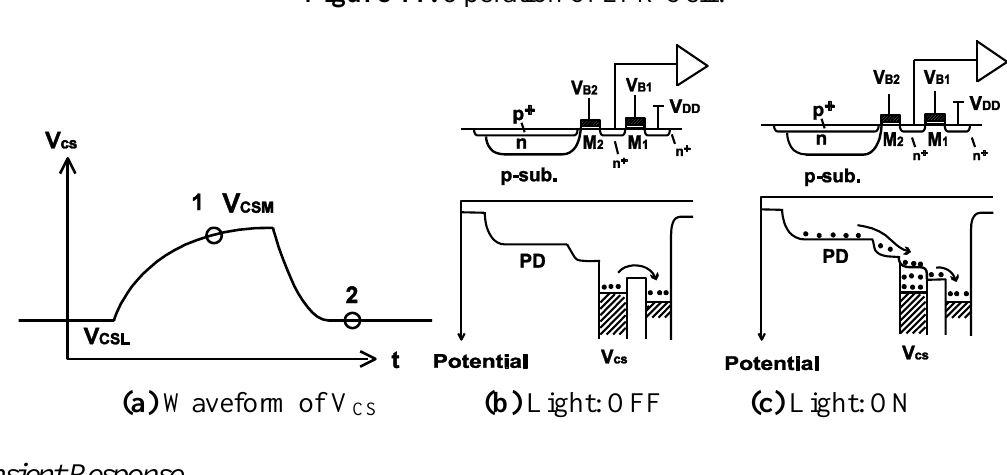
Figure 11. Operation of LPR